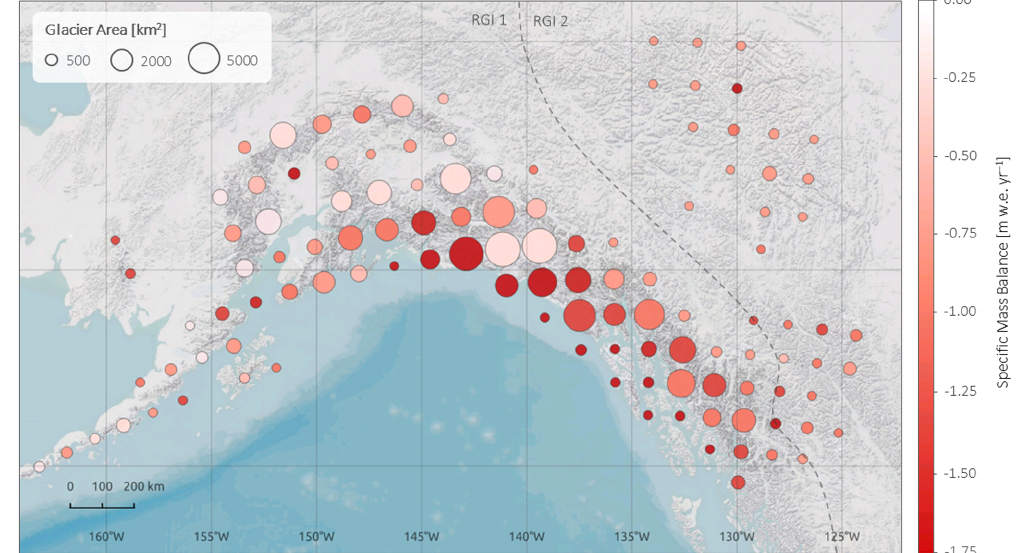
Figure 3. Specific glacier mass balance (mw.e.yr − 1 ) in the Gulf of Alaska (GoA) for the period of July 2010 to July 2019 on a 100 × 100km grid. The size of the circles is scaled by the total glacierized area within a cell. Note that our total mass change estimate of − 76 . 3 ± 5.7Gtyr − 1 ( − 0 . 89 ± 0.07mw.e.yr − 1 ) only includes glaciers from the RGI region 1 (Alaska). Including also the northern Rocky Mountains and the Mackenzie and Selwyn mountains, we retrieve a mass change of − 77 . 7 ± 5 . 7Gtyr − 1